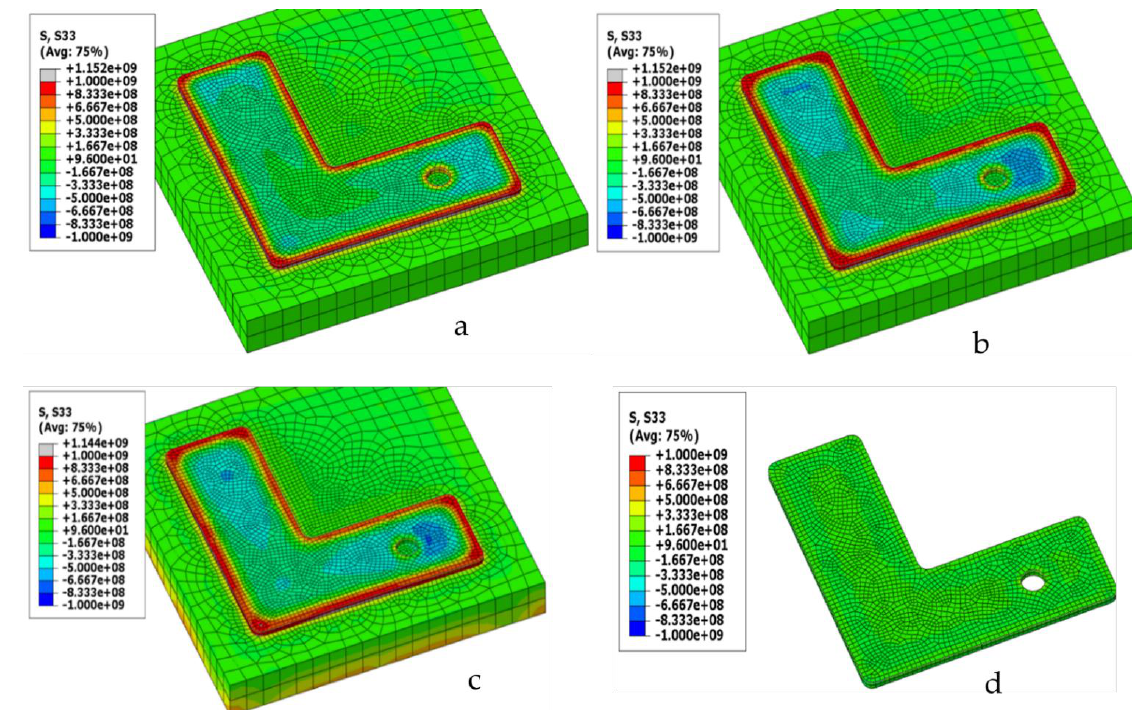
Figure 6. Stress evolution [Pa] in building direction for a layer at 2mm away from base plate for HB sample (sections above the current layers are removed for visualization) ( a ) just after new layer is printed and moved into powder bed. ( b ) When part height reached at 10 mm. ( c ) All layers are printed and cooled down to room temperature. ( d ) After removal from base plate.